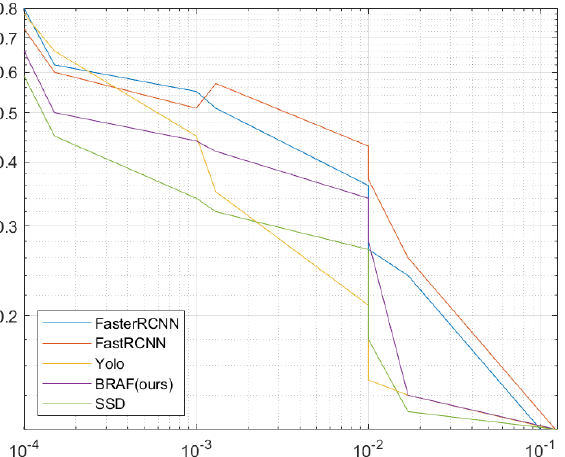
Figure 8. Missing Rate (MR) versus False Positive Per Character (FPPC) for training with default boxes for comparison of our FC-MSCCD model with other SOTA models.